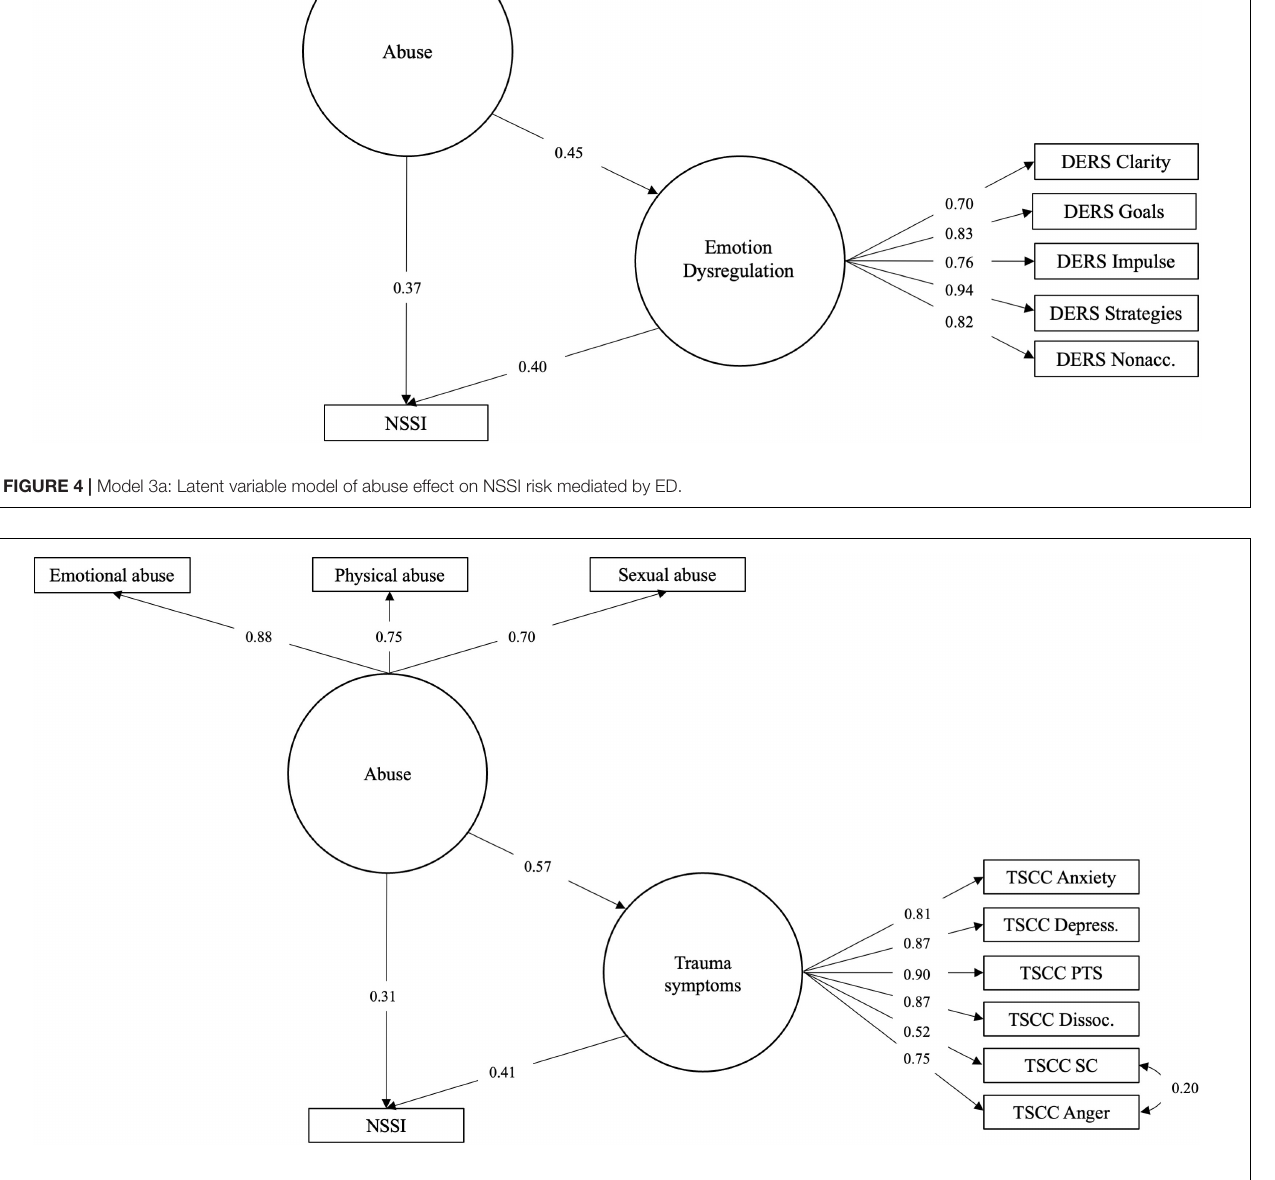
FIGURE 5 | Model 3b: Latent variable model of abuse effect on NSSI risk mediated by